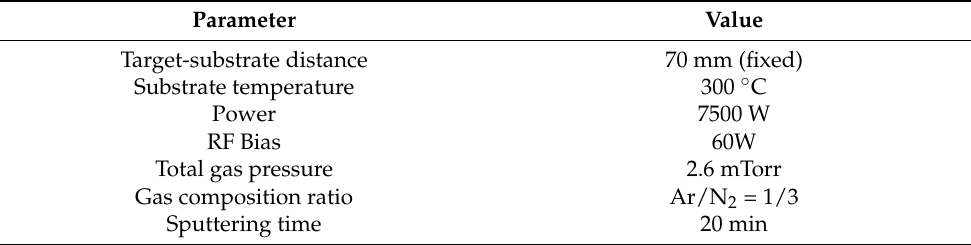
Table 1. The deposition